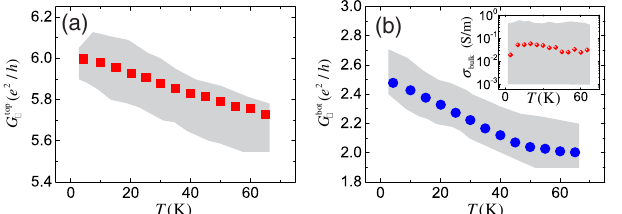
FIG. 9. Simulation results of G top □ and G bot □ , leading to the matching condition for the experimental data of V , V , and loc nloc 1 V simultaneously for temperatures in the range T < 70 K. nloc 2 The inset in (b) shows the corresponding temperature variation of σ . Grey shaded regions indicate the range of the variables bulk giving rise to the observed data (with fluctuations) within an j ≤ 1 μ V, j Δ V j ≤ 0 . 3 μ V, and uncertainty of j Δ V loc nloc 1 j Δ V j ≤ 0 . 05 μ V. The upper limit of σ is ∼ 0 . 6 S = m. nloc 2 bulk Symbols indicate the weighted average